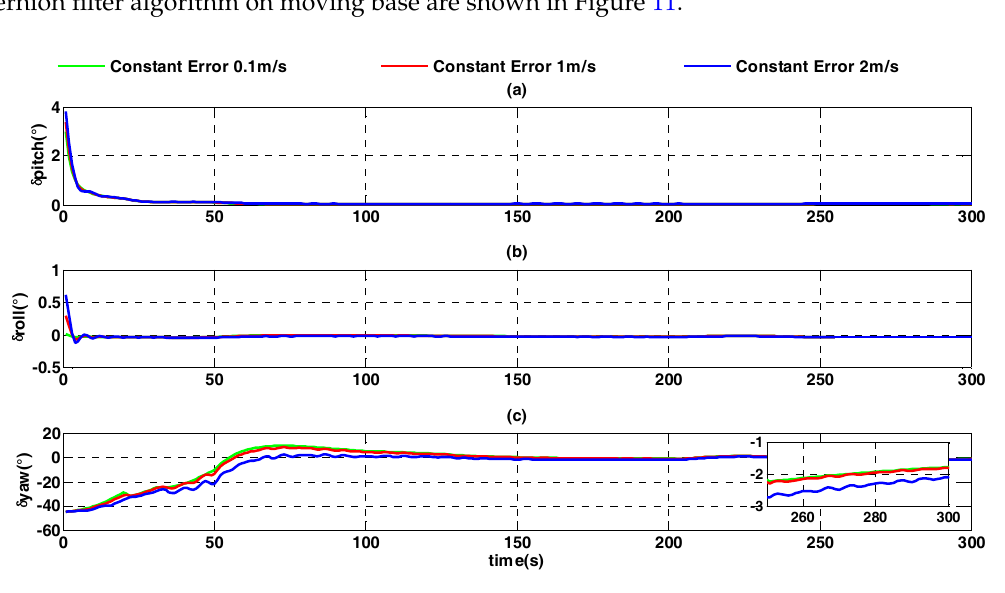
Figure 10. Compensation mode of velocity difference.